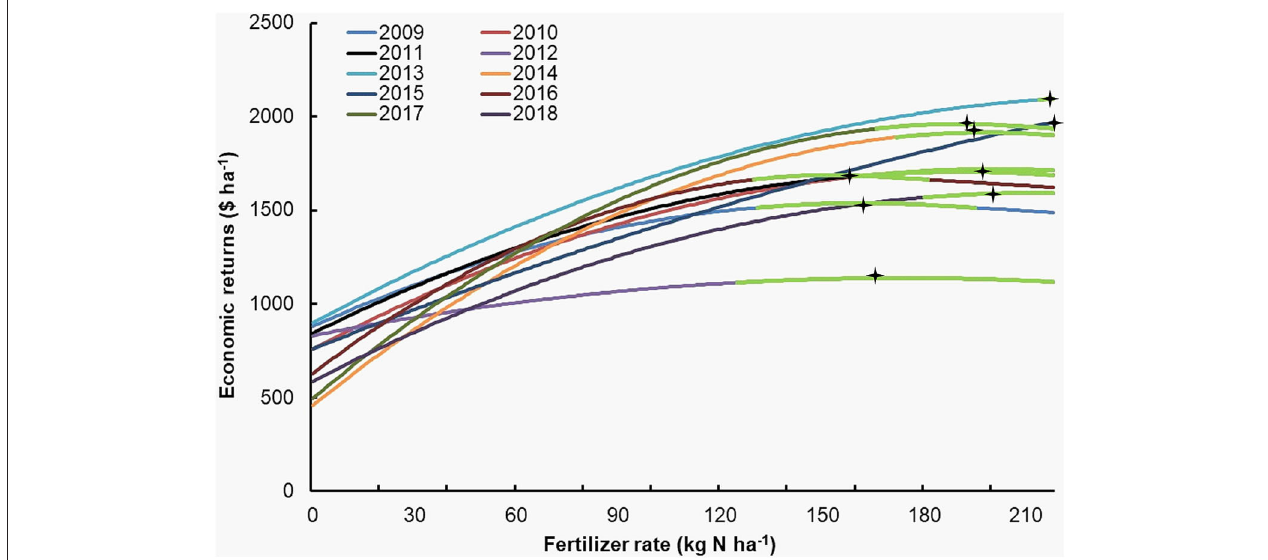
FIGURE 4 | Relationship between net returns to nitrogen costs and nitrogen rates during 2009–2018. The underlying yield responses were fitted using a quadratic-plateau model. After N cost return response was calculated as the value of com estimated from quadratic plateau yield response equations subtract the cost of N required to attain the estimated yield. Green colored line indicates the threshold within 25$ ha − 1 of economic profits. Star indicates the maximum economic rate of nitrogen